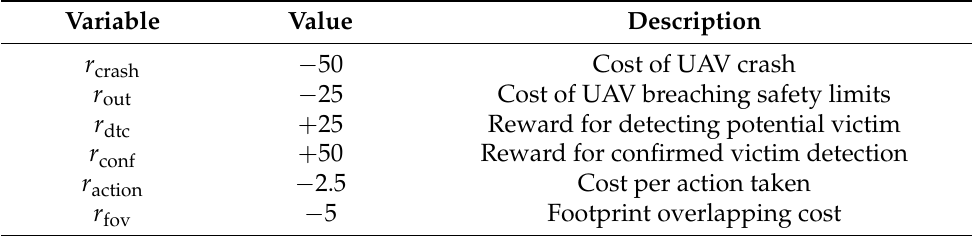
Table 2. Applied reward values to the reward function R , defined in Algorithm